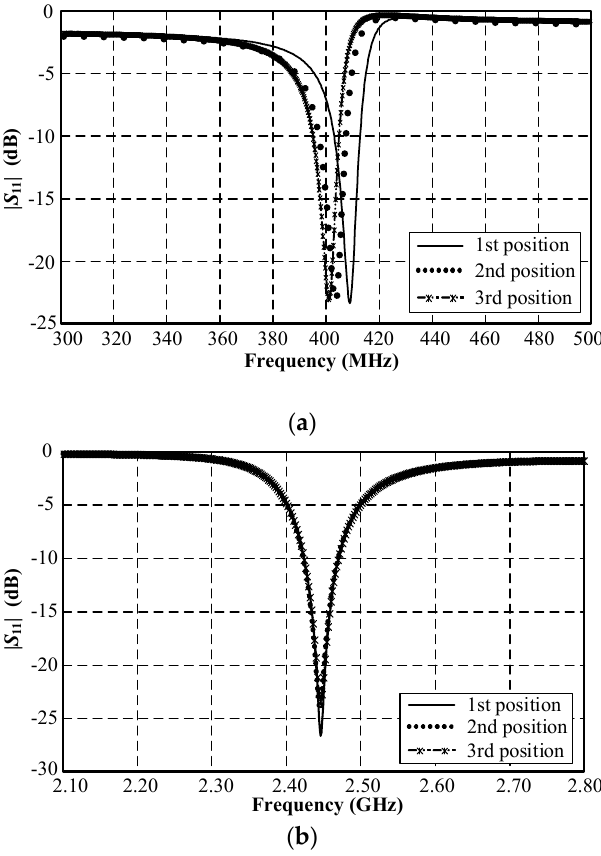
Figure 11. Simulated |S 11 | of the MICS/ISM meander-line microstrip antenna along the digestive tract where the 1st, 2nd, and 3rd positions indicate the throat, stomach, and intestine: ( a ) MICS and ( b ) ISM bands. Table 4. Comparison of the optimization